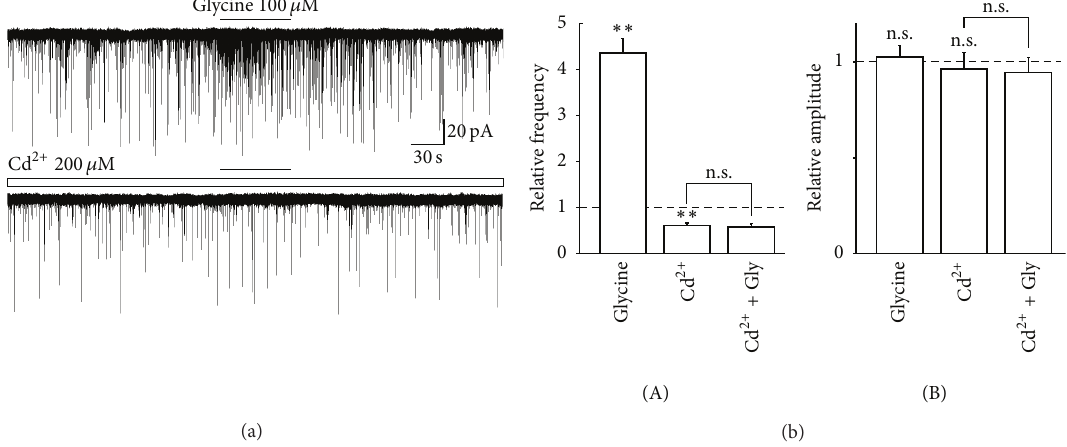
Figure 5: Effect of Cd 2+ on glycine-induced increase in sEPSC frequency. (a) Typical traces of glutamatergic sEPSCs observed during the application of 100 𝜇 M glycine in the absence (upper) and presence (lower) of 200 𝜇 M Cd 2+ . (b) Glycine-induced changes in frequency (A) and amplitude (B) of sEPSC in the absence and presence of Cd 2+ . Note that the glycine-induced facilitation of sEPSC frequency was completely suppressed by Cd 2+ . Each column was the mean and SEM from 7 neurons. ∗∗ 𝑃 < 0.01 ; n.s.: not significant.